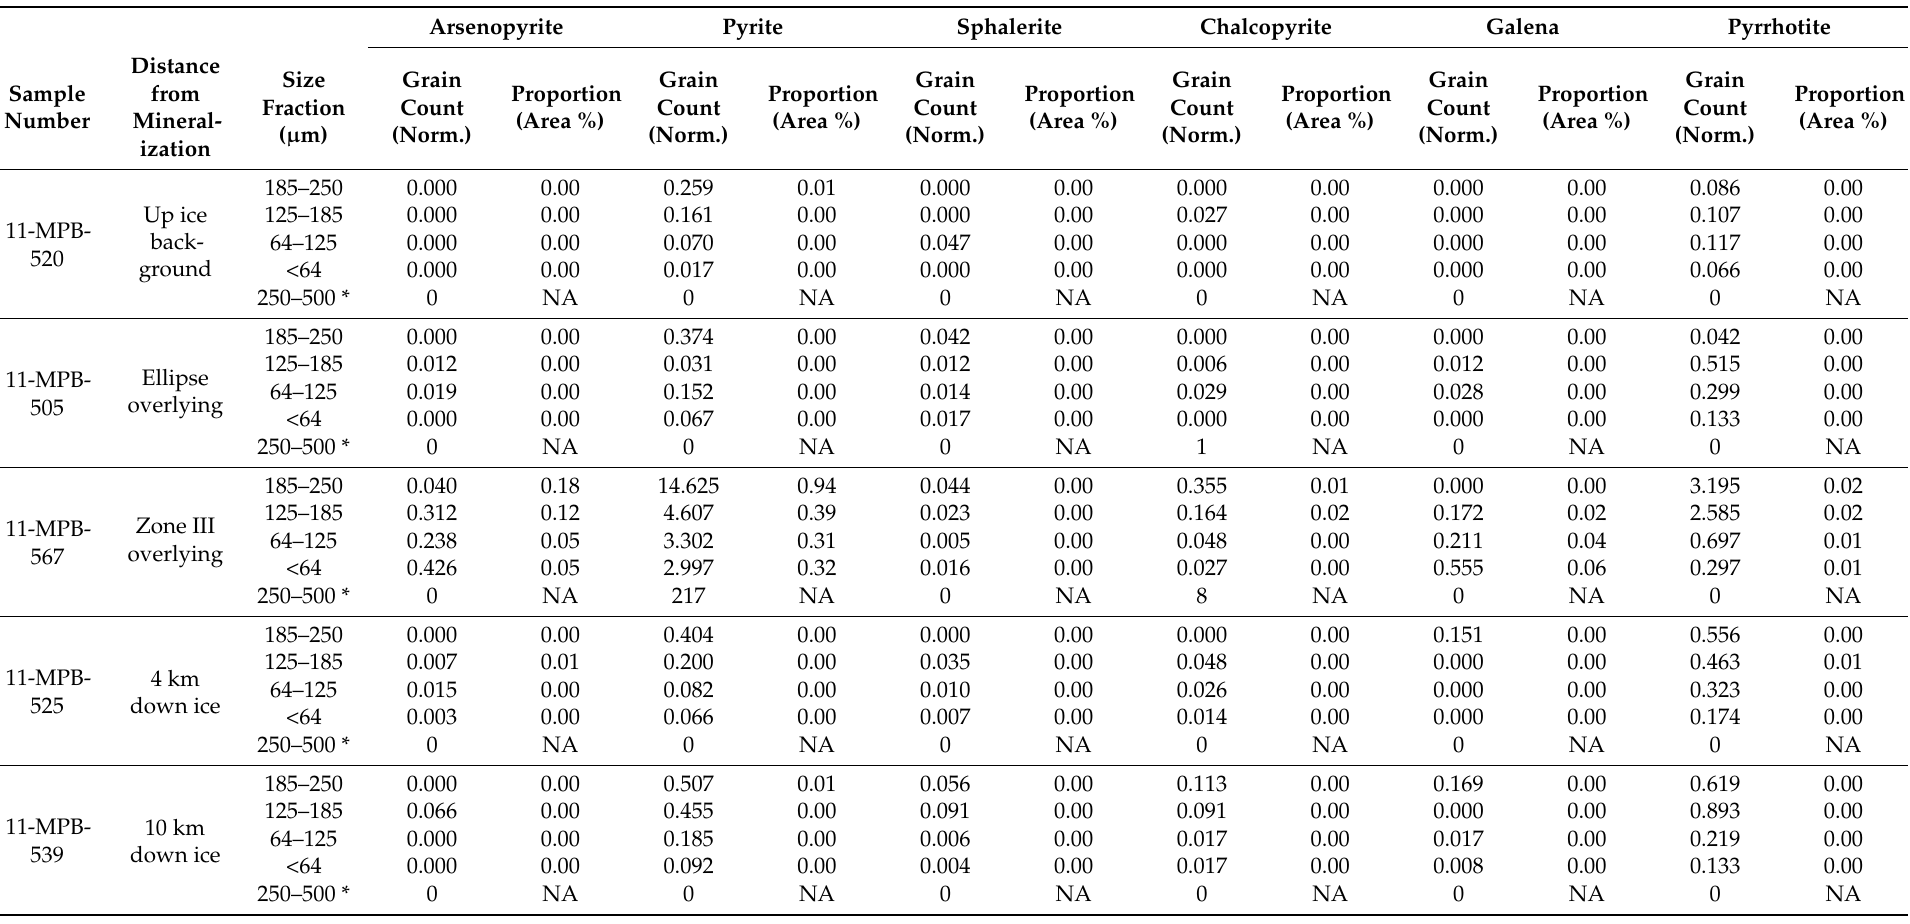
Table 5. Abundance of ore indicator minerals in five till sample up- and down ice of the Sisson W-Mo deposit. Mineral abundance data are reported in two ways: (1) number of indicator mineral grains per total grains, normalized to 1000 grains; (2) minerals by 2-dimensional percentage area they take up on the polished mount surface. Also included are grain counts from the coarse (250 to 500 µ m) heavy mineral fraction of the same sample obtained by visual grain picking that have been normalized to a 10 kg of sample mass (data from McClenaghan et al.